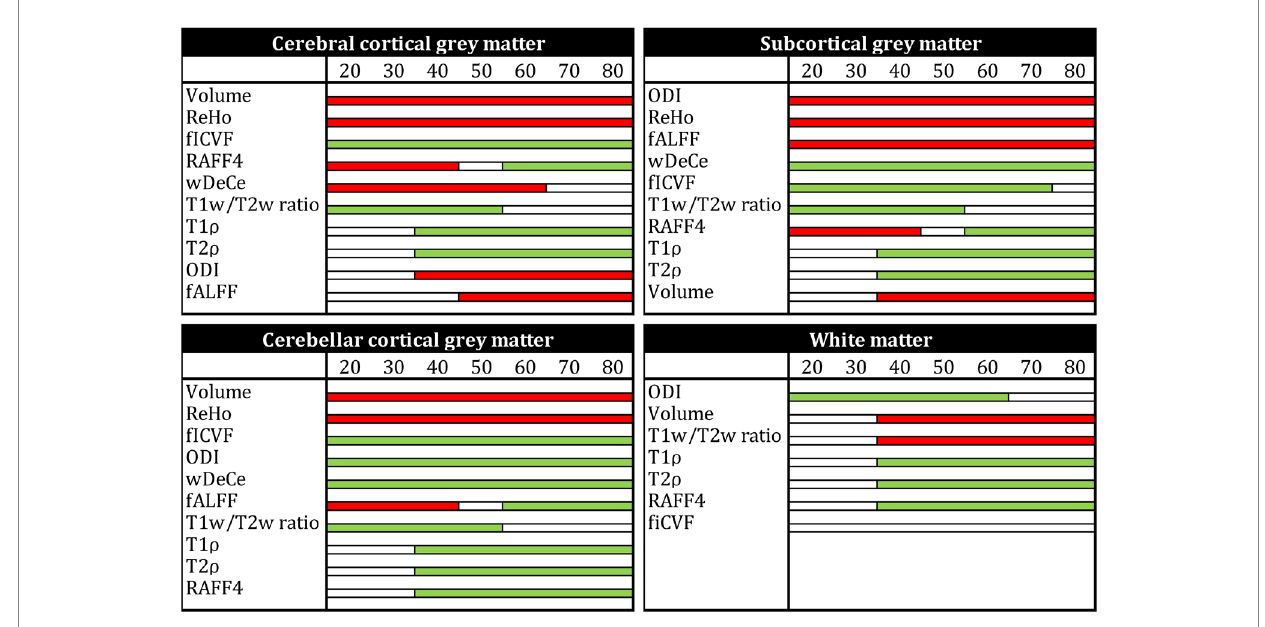
FIGURE 3 Simplified overview of ages when individual MRI metrics are able to detect underlying changes (in ascending order), for each of the four regions of interest [cerebral cortical grey matter (GM), subcortical GM, cerebellar cortical GM and white matter (not provided for resting-state fMRI metrics)]. Normalised volume, T1w/T2w ratio, T1 ρ , T2 ρ , rank 4 Relaxation Along a Fictitious Field (RAFF4), intracellular volume fraction (fICVF), orientation dispersion index (ODI), weighted Degree Centrality (wDeCe), regional homogeneity (ReHo), and fractional amplitude of low-frequency fluctuations (fALFF) are presented. Red colour or the bar denotes a descending trend of the MRI metric, green colour an ascending trend and white bar marks plateau/no change in the respective age